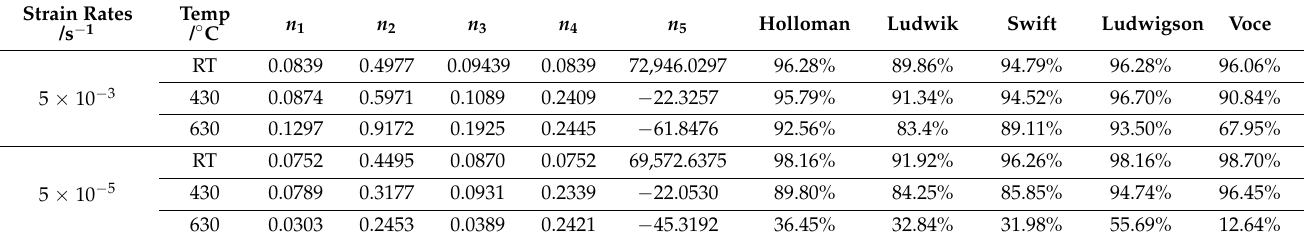
Table 2. Fitted values and error analysis for different flow relationships at the strain rates of 5 × 10 − 3 s − 1 and 5 × 10 − 5 s − 1